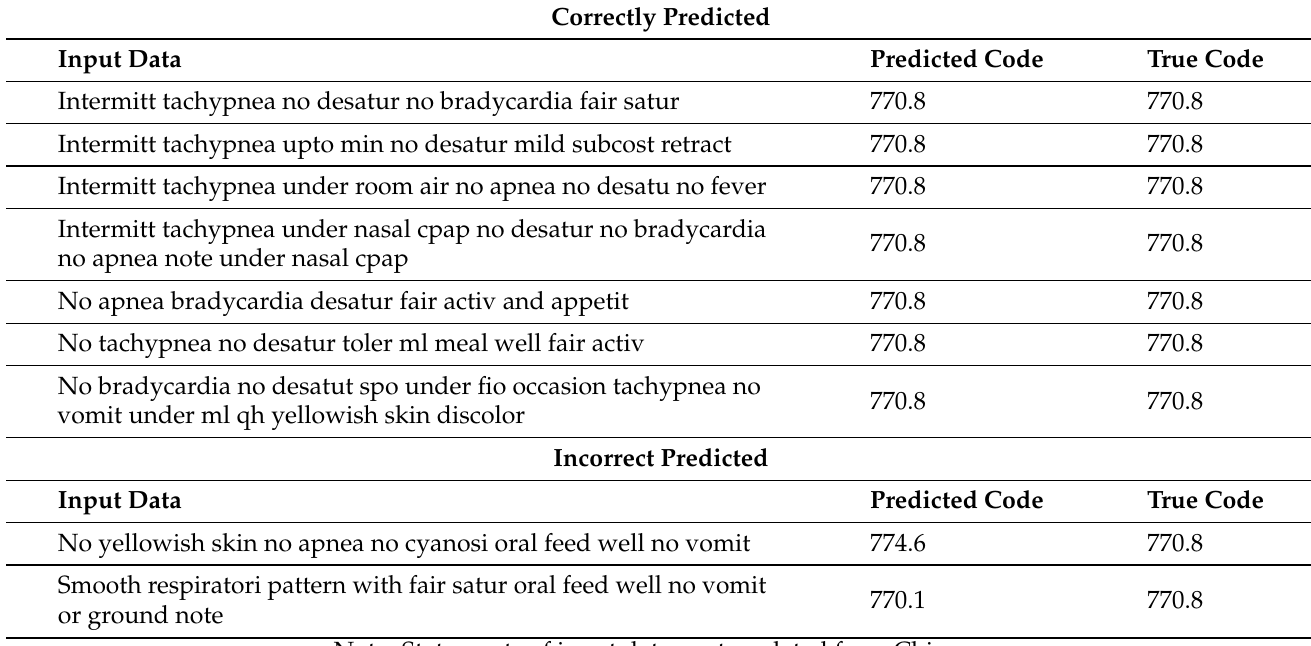
Table 12. Discussion of 770.8 ICD-9-CM code prediction